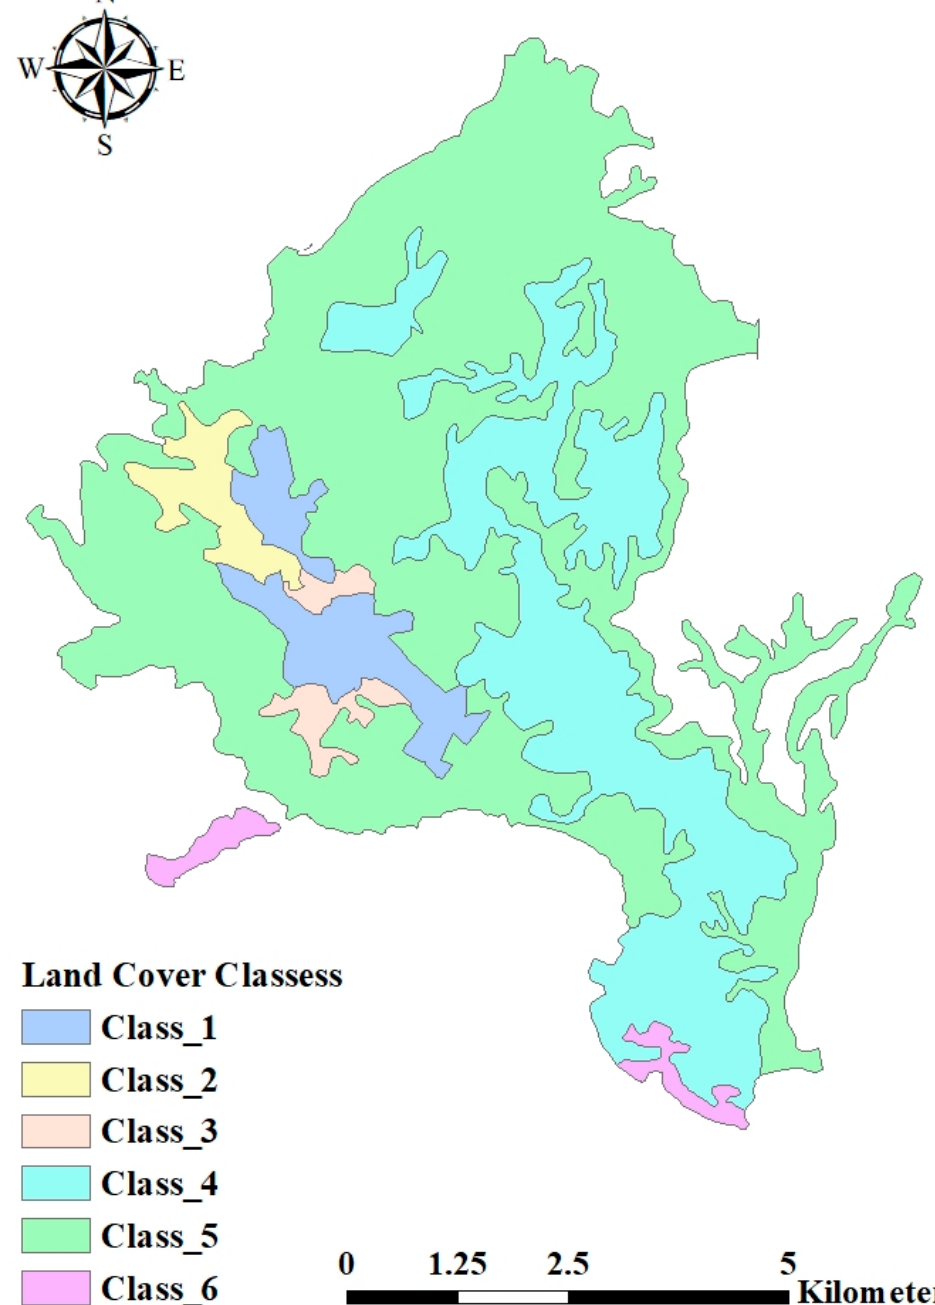
Figure 2. Supervised Land Cover Land Use classes of the designated study area.